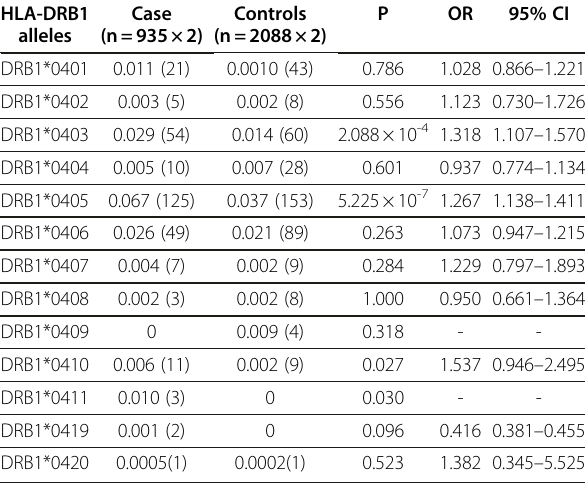
Table 4 A comparison of the frequencies of HLA-DRB1*04 subtypes in primary IgAN patients and healthy controls